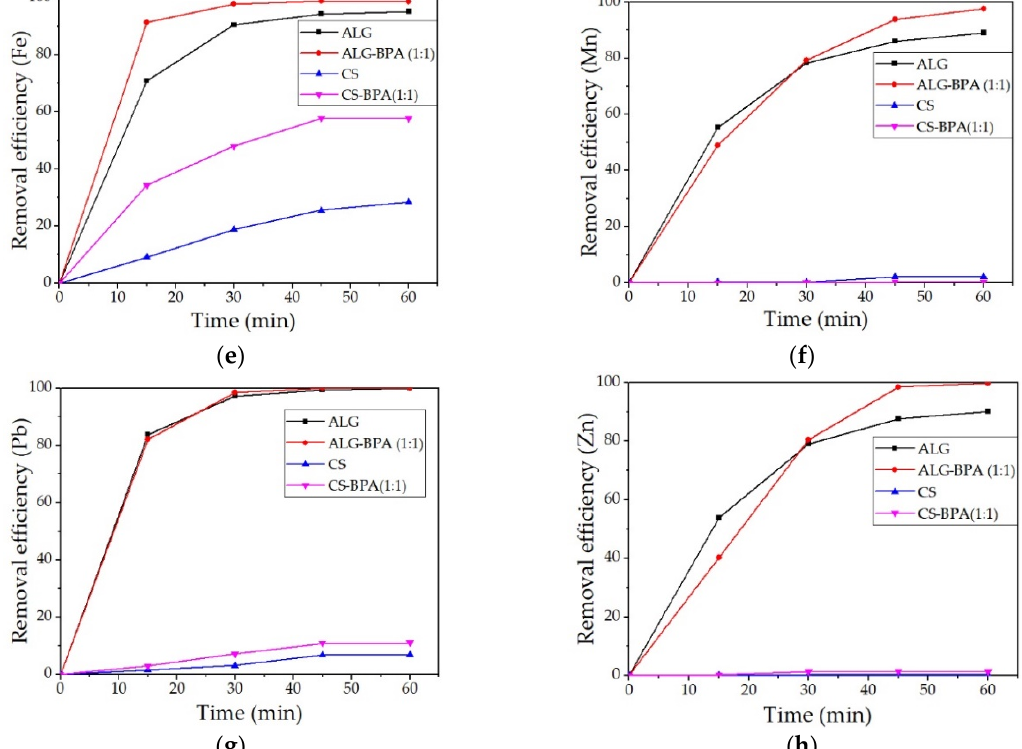
Figure 19. Removal efficiencies of the 4 types of microbeads for the metals studied: Cd ( a ), Co ( b ), Cr ( c ), Cu ( d ), Fe ( e ), Mn ( f ), Pb ( g ), and Zn ( h ).